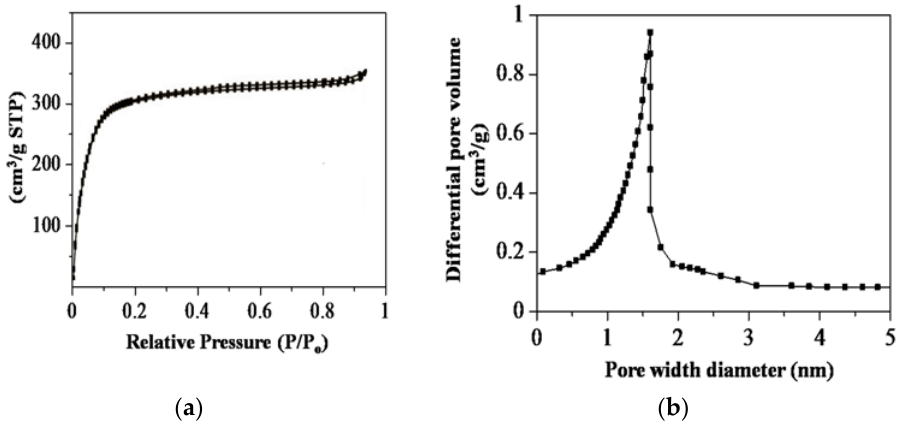
Figure 7. Nitrogen adsorption ‐ desorption measurements ( a ) Isotherms plot; and ( b ) Barrett, Joyner and Halenda method (BJH) models.